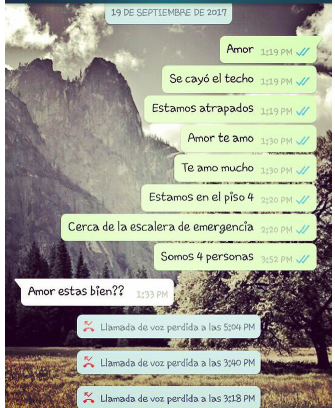
Figure 1. An earthquake survivor uses the WhatsApp messaging system to describe their situation inside a collapsed building. The messages translated to English are My love. The roof fell. We are trapped. My love I love you. I love you so much. We are on the 4th floor. Near the emergency staircase. There are 4 of us. My love are you ok? As a result of these messages, rescue teams were able to save the individuals trapped in the rubble